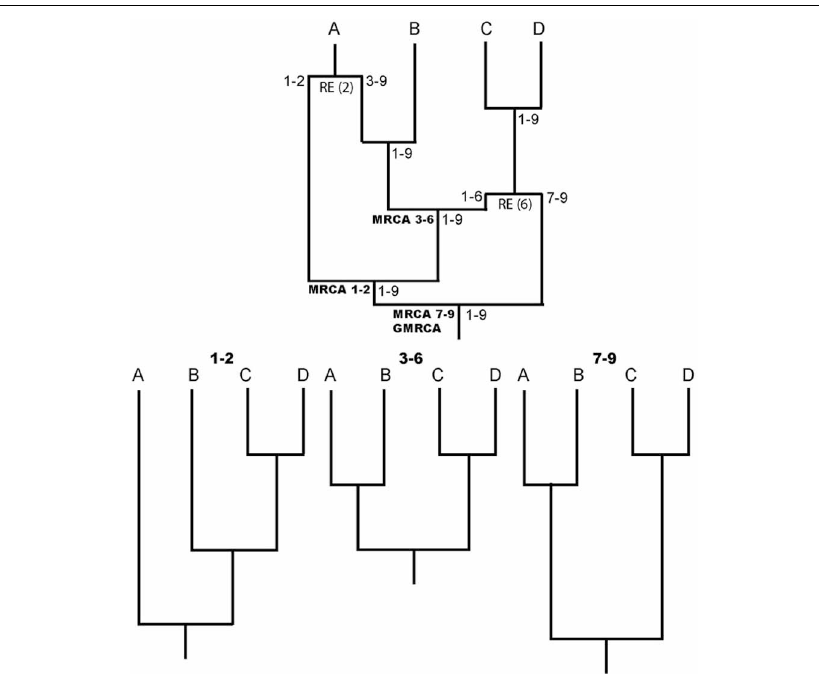
FIGURE 1 | Illustrative example of an ARG. RE indicates recombination events. Numbers in nodes indicate intervals of ancestral material. Note that each recombinant fragment (1–2, 3–6,